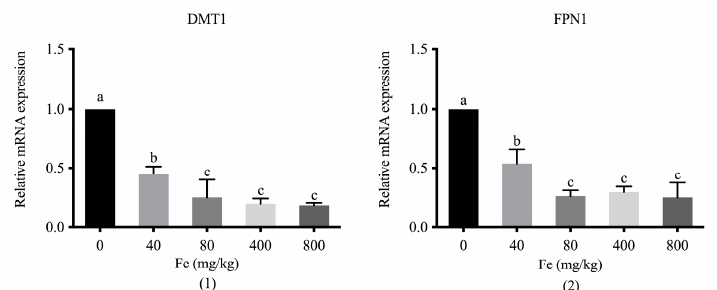
Figure 2. The relative mRNA expression of DMT1 (1) and FPN1 (2) in the duodenum of 42 ‐ day ‐ old broilers fed with different doses of Fe–LG. DMT1, divalent metal transporter 1; FPN1, ferroportin 1. a–c Bars without the same letters differ significantly ( p < 0.05).